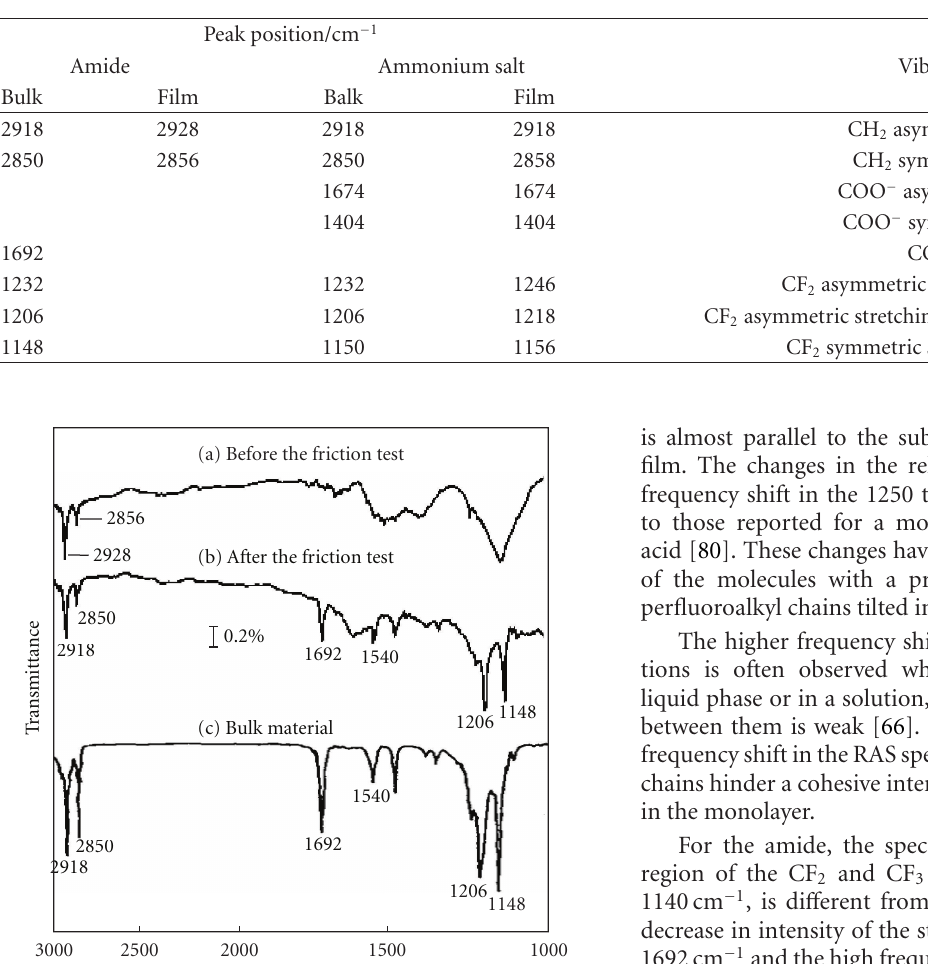
Table 5: Mode assignment and peak positions for the ammonium salt and amide in KBr and as adsorbed on a magnetic layer.